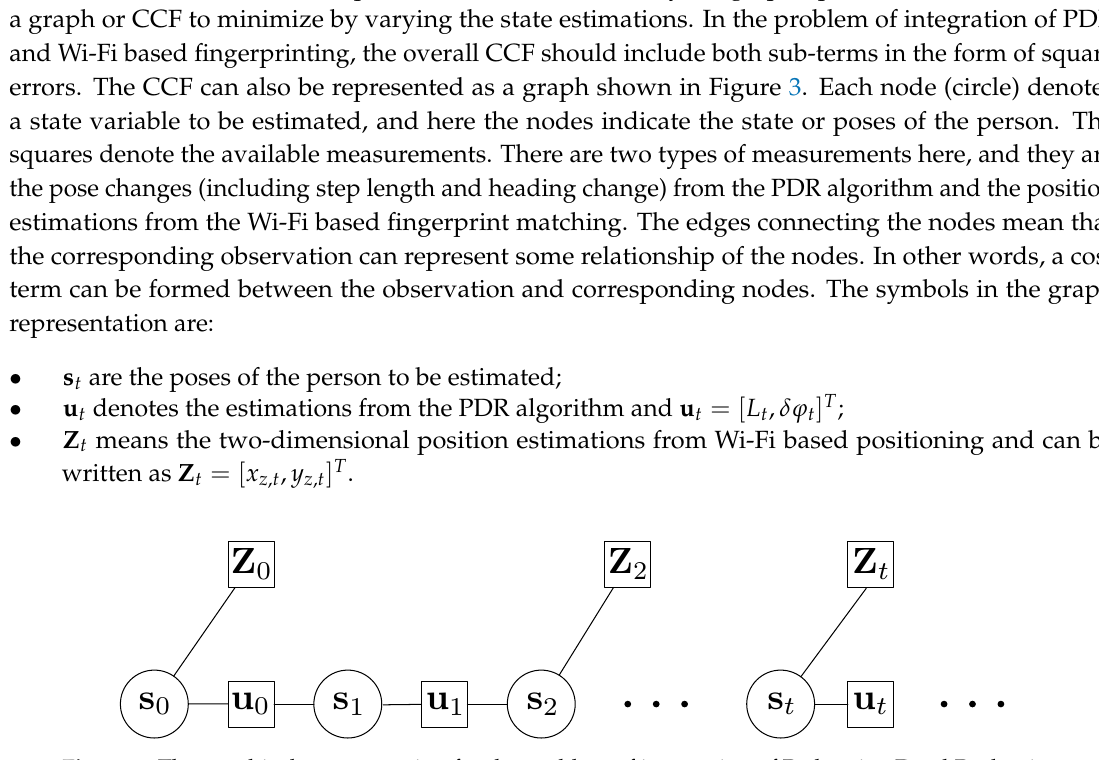
Figure 3. The graphical representation for the problem of integration of Pedestrian Dead Reckoning (PDR) based position estimations and Wi-Fi based